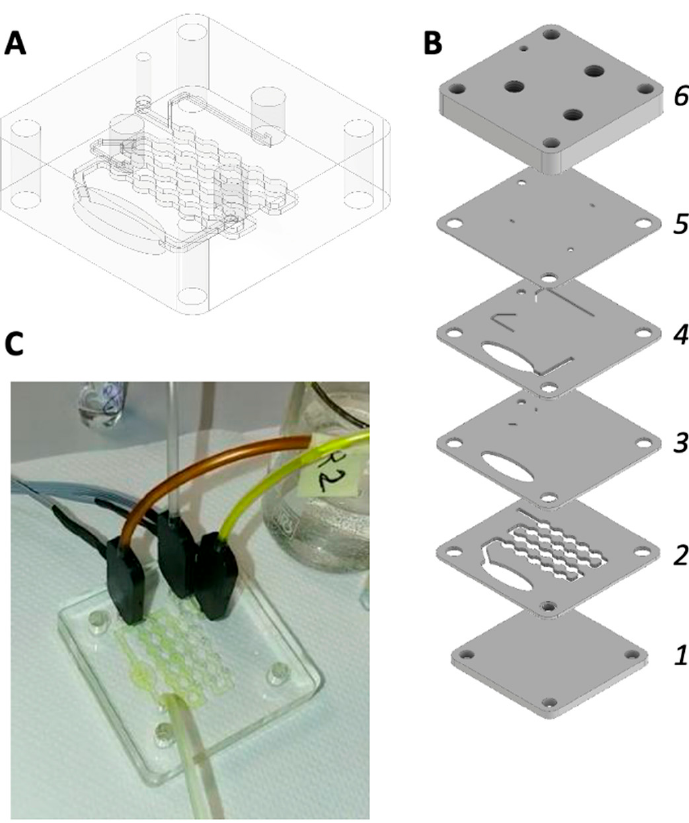
Figure 1. Microfluidic chip: ( A ): Assembly view. ( B ) Exploded view: 1: bottom lid (thickness: 3 mm); 2: mixer and measurement well (thickness: 1 mm); 3: spacer (thickness: 1 mm); 4: reagents channels (thickness: 1 mm); 5: spacer (thickness: 0.5 mm); 6: top lid (thickness: 8 mm). ( C ): picture of the chip connected to reagents and sample inlet and wastes